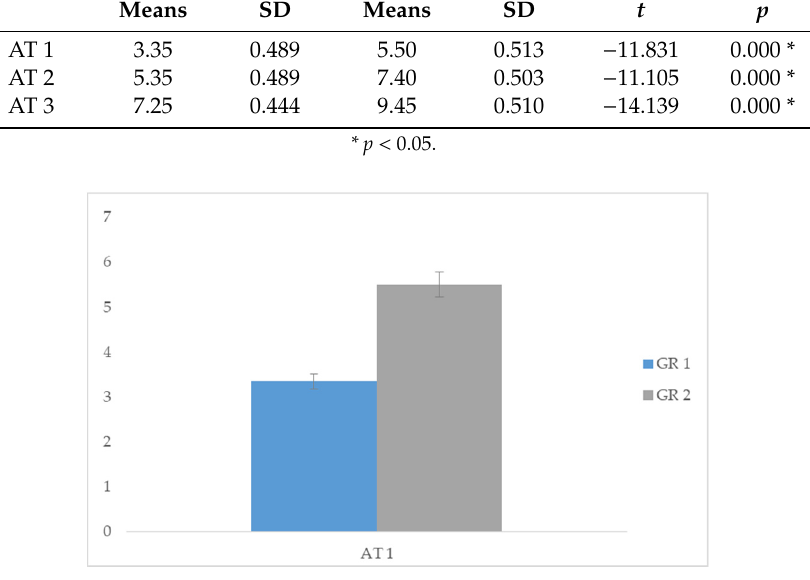
Figure 2. Comparison of AT1 task acquisition times between GR 1 (group 1) and GR 2 (group 2).